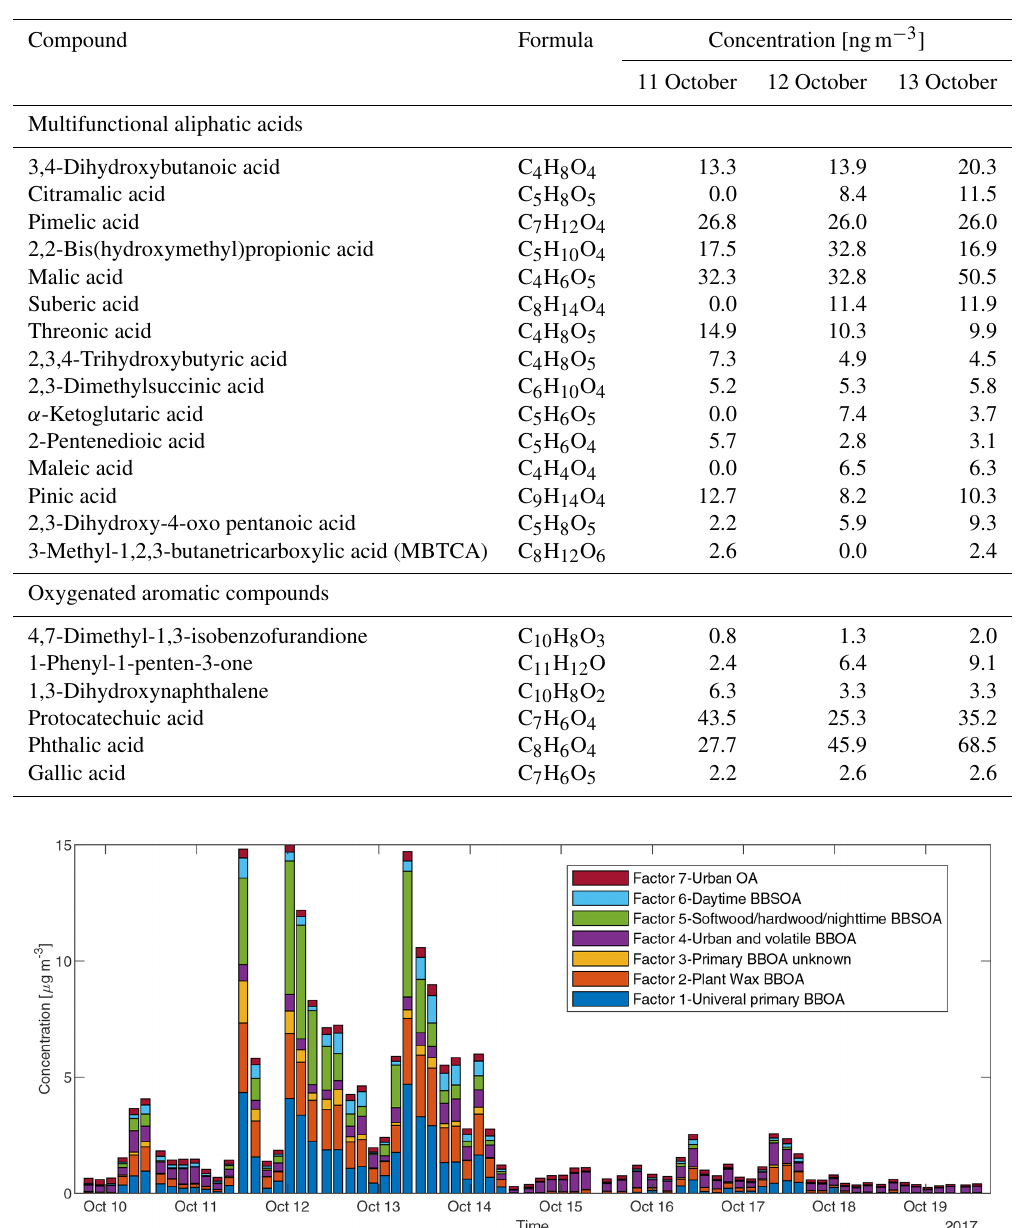
Figure 8. Sum of concentrations of GC × GC speciated and quantified compounds in different factors in each